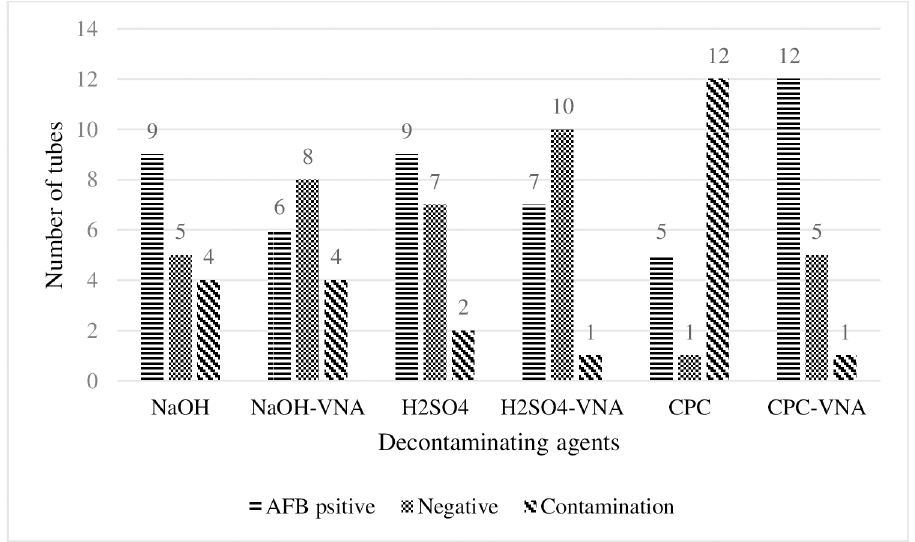
Fig 3. Number of tubes showing growth of M . avium subsp avium recovered from spiked fecal samples after six decontamination procedures. Bars show sum of AFB positive cultures, AFB negative cultures and contaminated cultures obtained from three inocula. When decontaminants were followed by VNA, a decrease in contamination rate was observed with all procedures, however the proportion of positive cultures increased with CPC 1%.